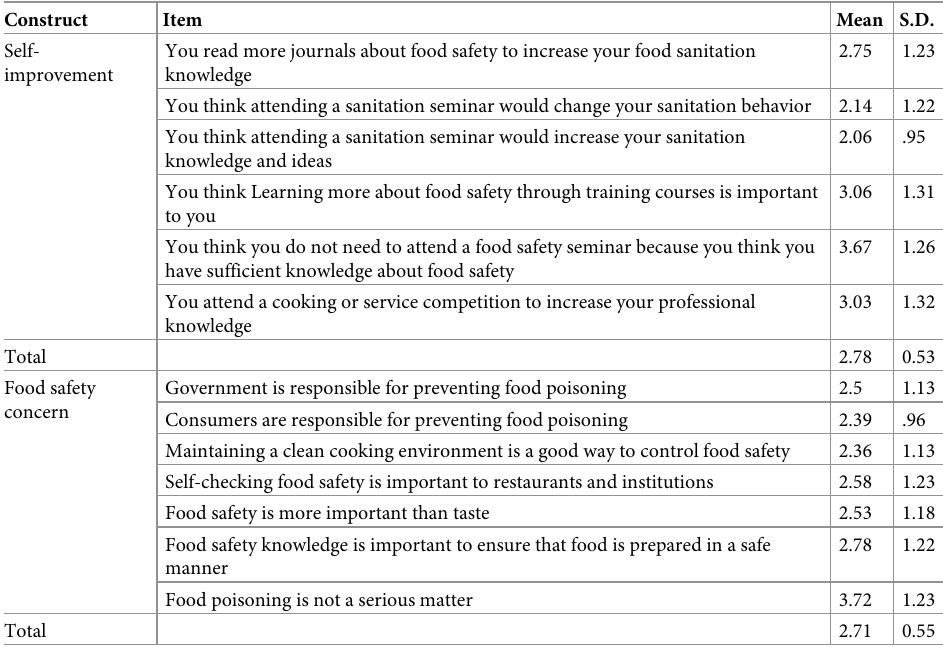
Table 3. Mean values of participants’ food safety attitude scores.